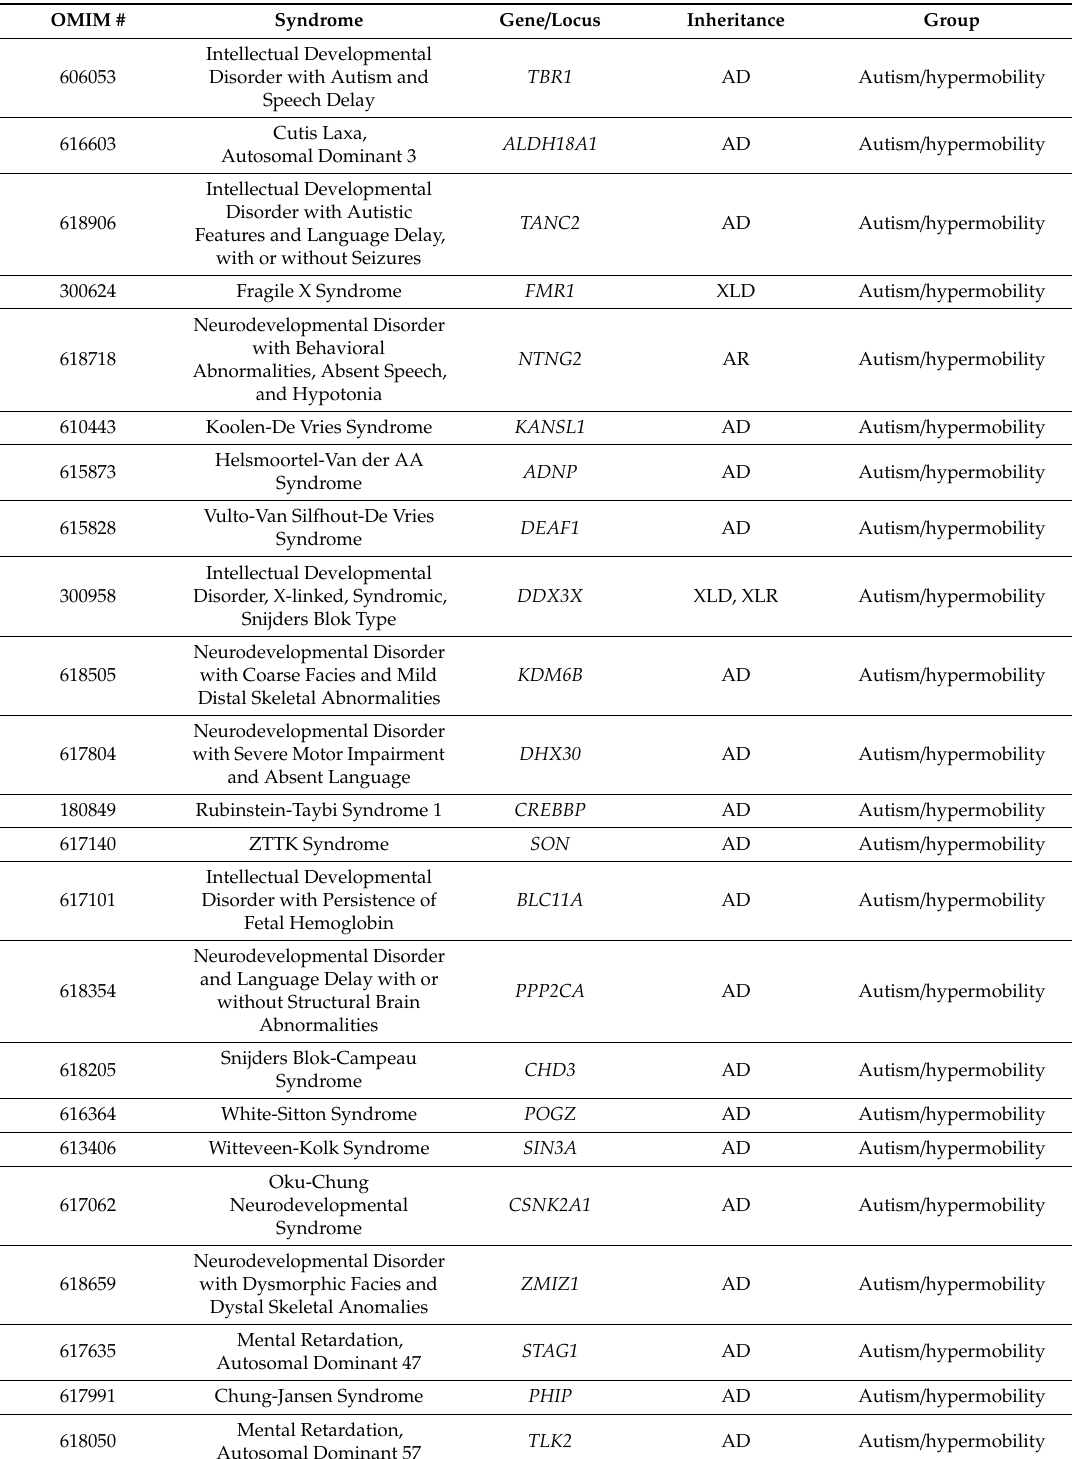
Table 1. Genetic syndromes and their associated genes derived from the Online Mendelian Inheritance in Man (OMIM) database. These syndromes are either associated with autism and hypermobility or the Ehlers-Danlos syndromes. Autosomal dominant = AD; autosomal recessive = AR; X-linked dominant = XLD; X-linked recessive = XLR; unknown inheritance pattern =